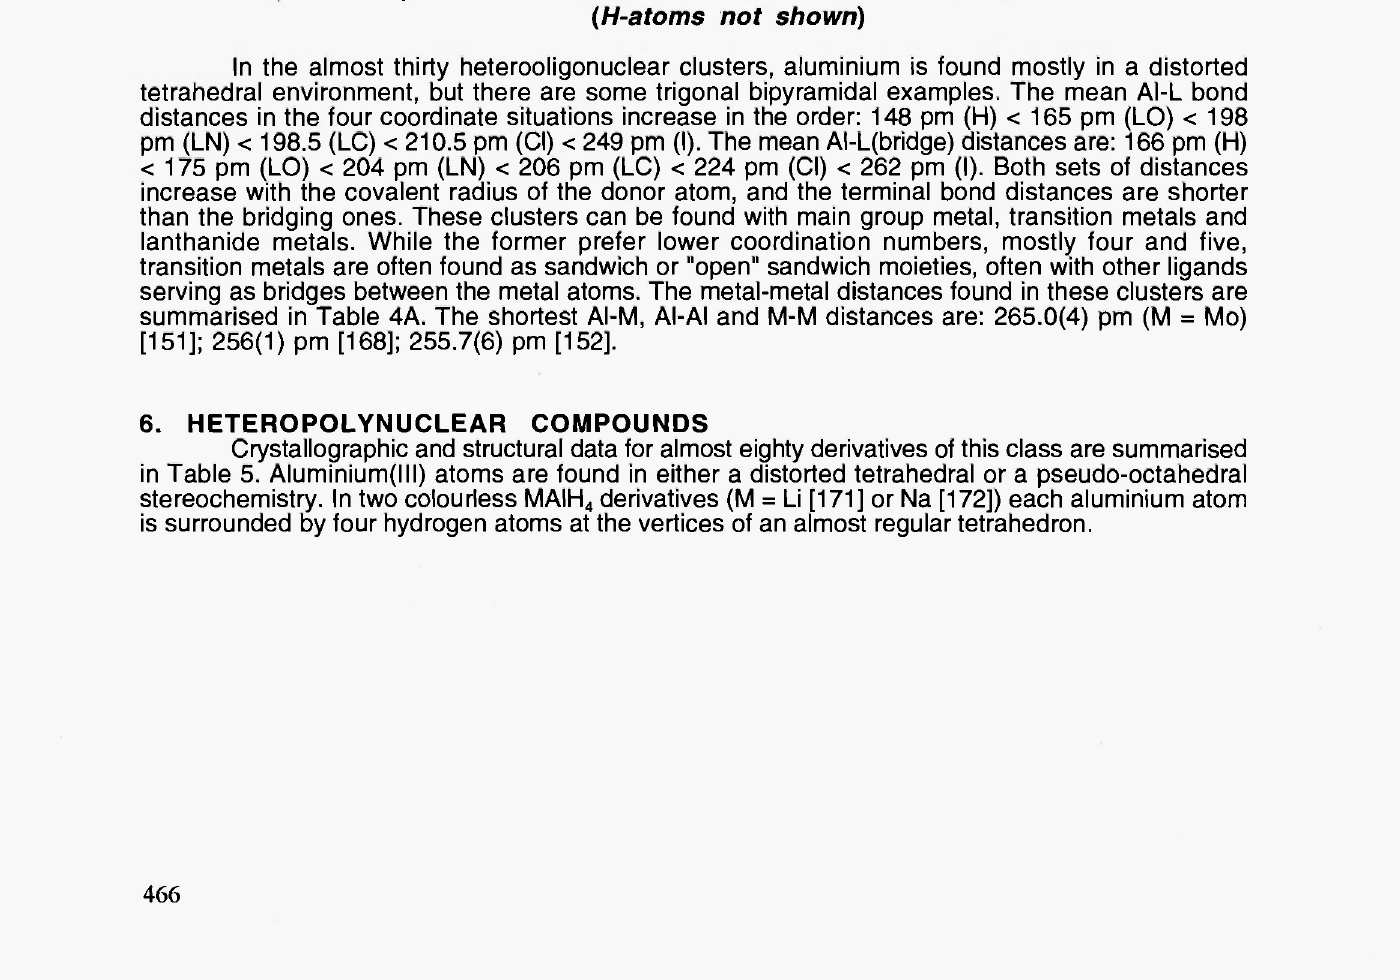
Fig.14. Structure of (cp Zr)